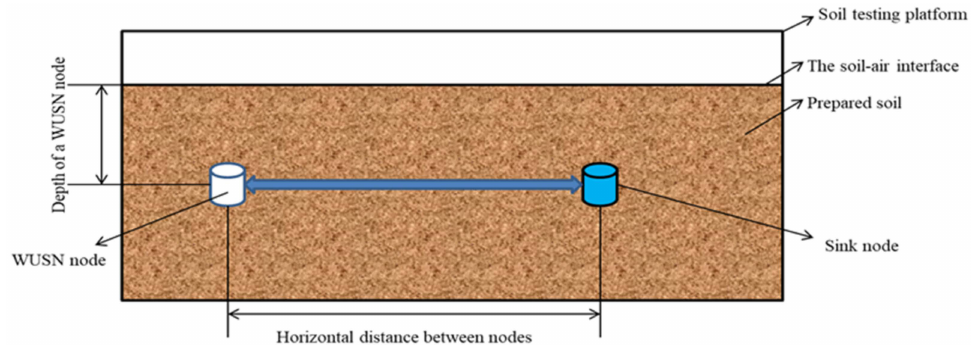
Figure 4. Schematic diagram of WUSN node communication test on the soil test